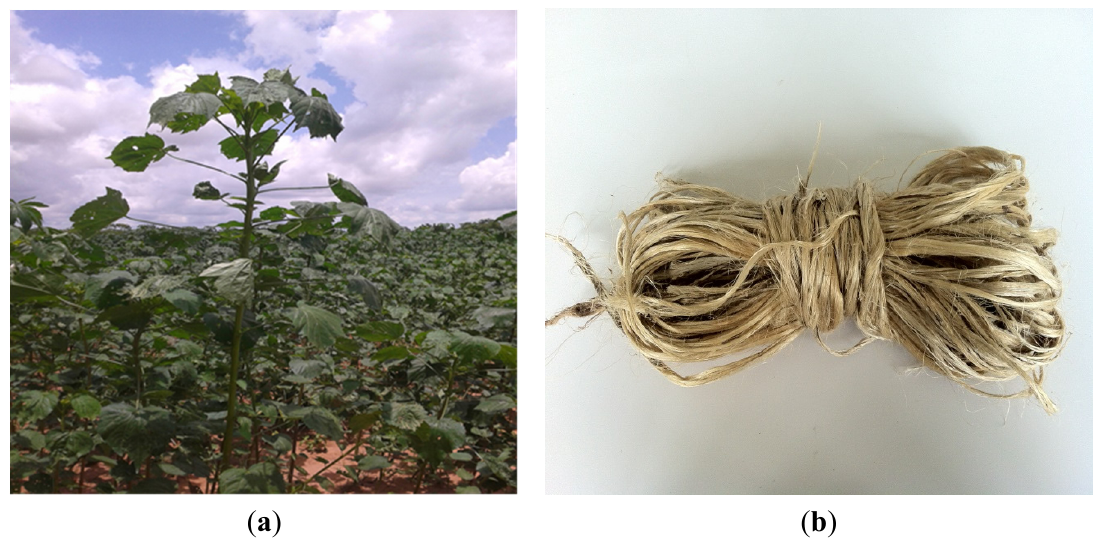
Figure 1. Pictures of kenaf plant ( a ) and extracted fibers ( b